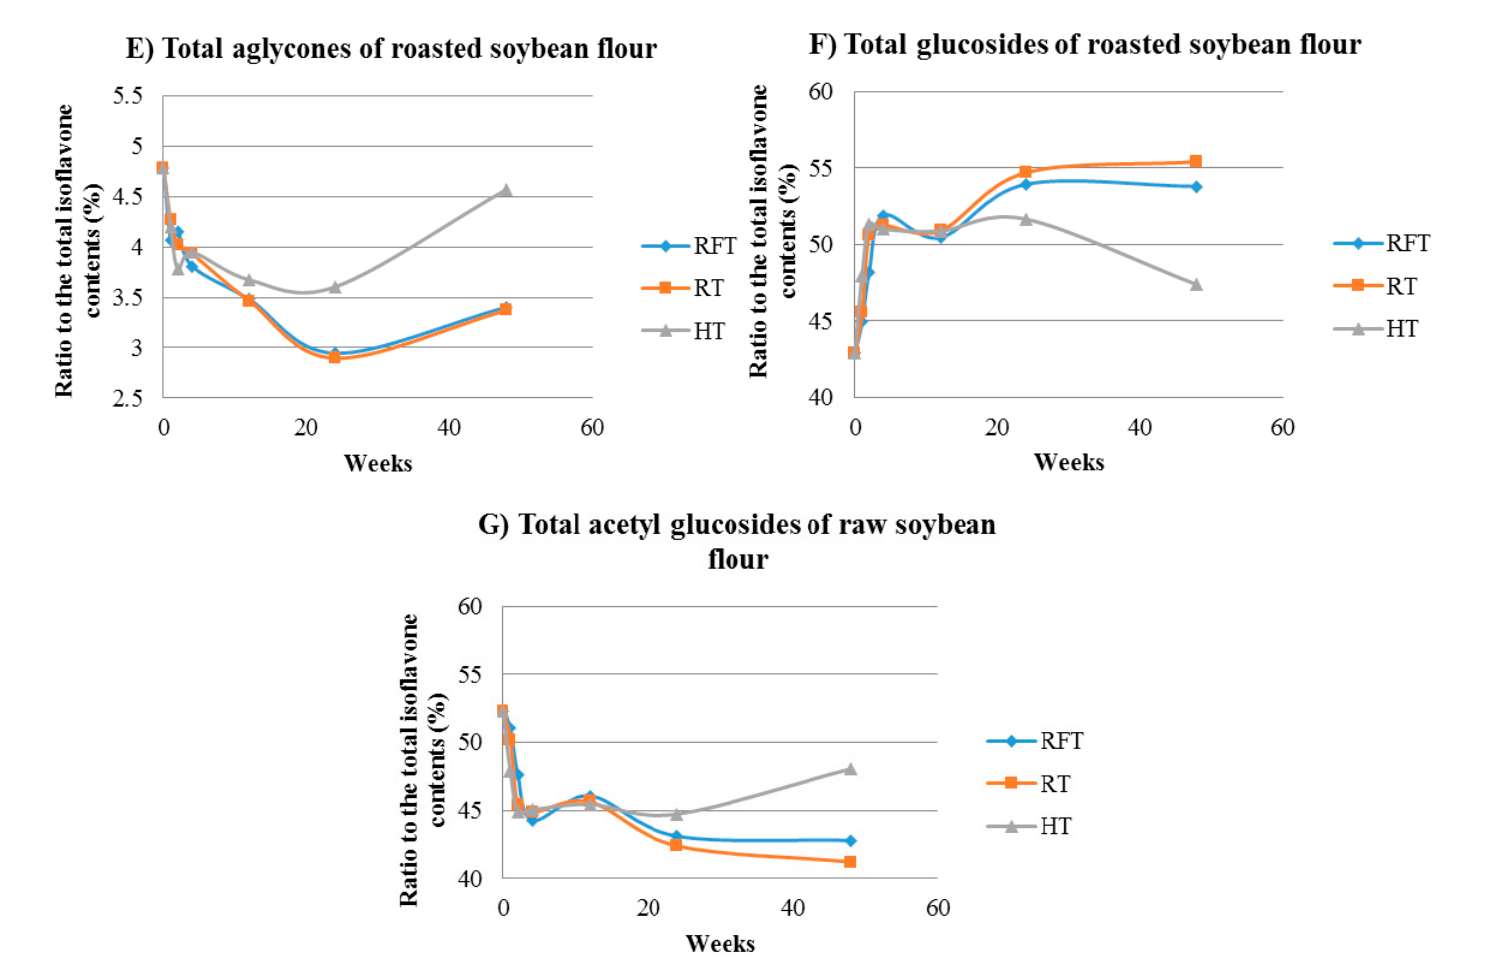
Figure 8. Changes of the isoflavone groups according to the storage time (control, 1, 2, 4, 12, 24, and 48 weeks) and temperature. RFT: Refrigerated temperature (4 °C); RT: Room temperature (20 °C); HT: High temperature (45 °C). Isoflavone content of each storage time indicates the ratio of the sum of each isoflavone group over the sum of total isoflavones.